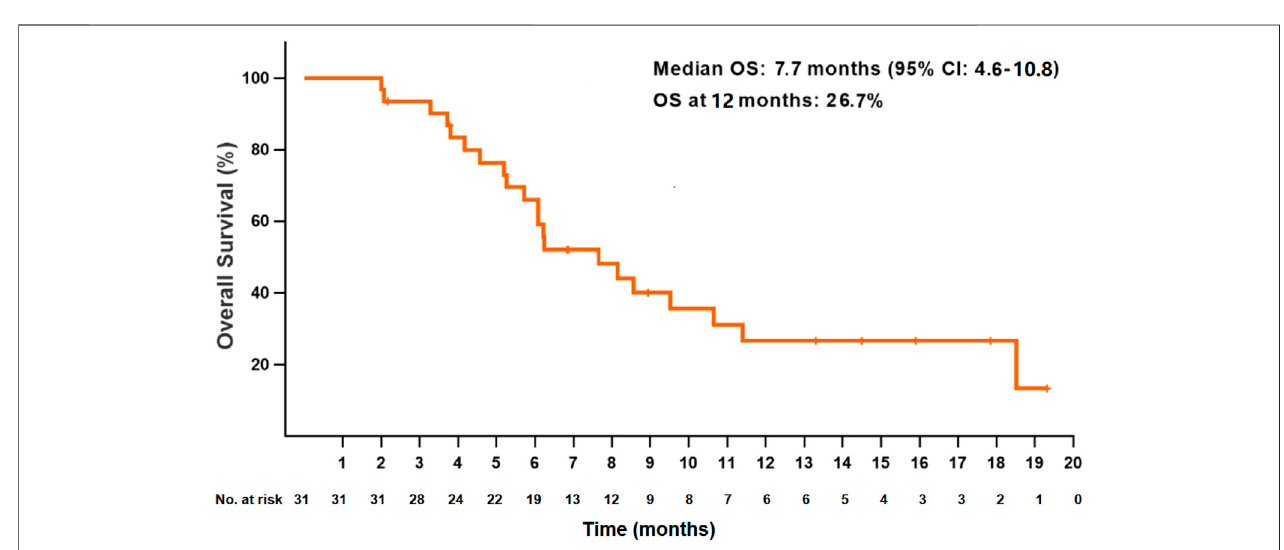
FIGURE 2 | Kaplan – Meier plot of overall survival in all